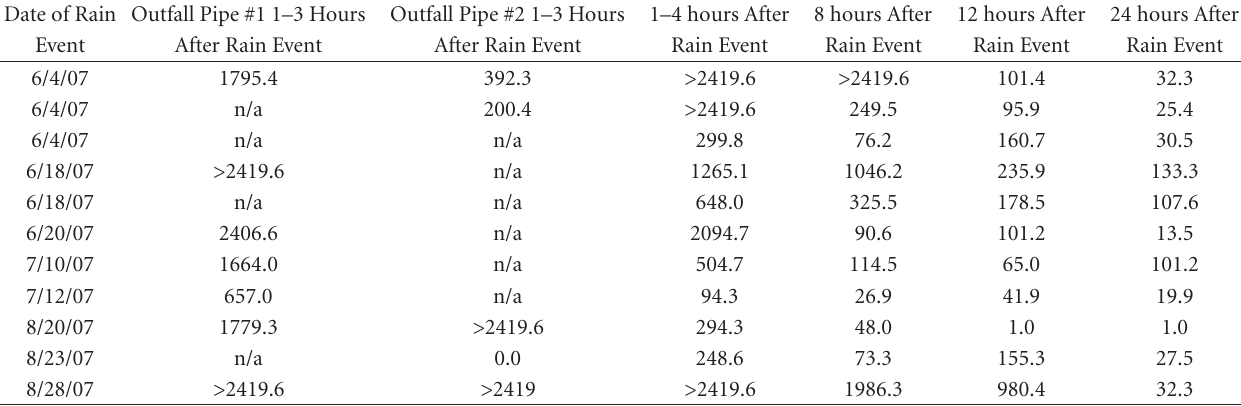
Table 7: E. coli concentrations ( ∗ MPN/100mL) from beach water collected at time intervals following the triggering of a rain event at Sister Bay beach. Using Sche ff e matrix analysis, E. coli concentrations measured in the first four hours after the rain event was triggered were significantly di ff erent from the seasonal mean E. coli concentration for this beach ( P < . 001). Likewise, E. coli concentrations measured at 8 hours or 12 hours after the rain event was triggered were significantly di ff erent from the seasonal mean E. coli concentration for this beach ( P < . 001 and P < . 024, resp.). If rainfall was su ffi cient to trigger multiple rain event notifications on one day, then multiple events were sampled.